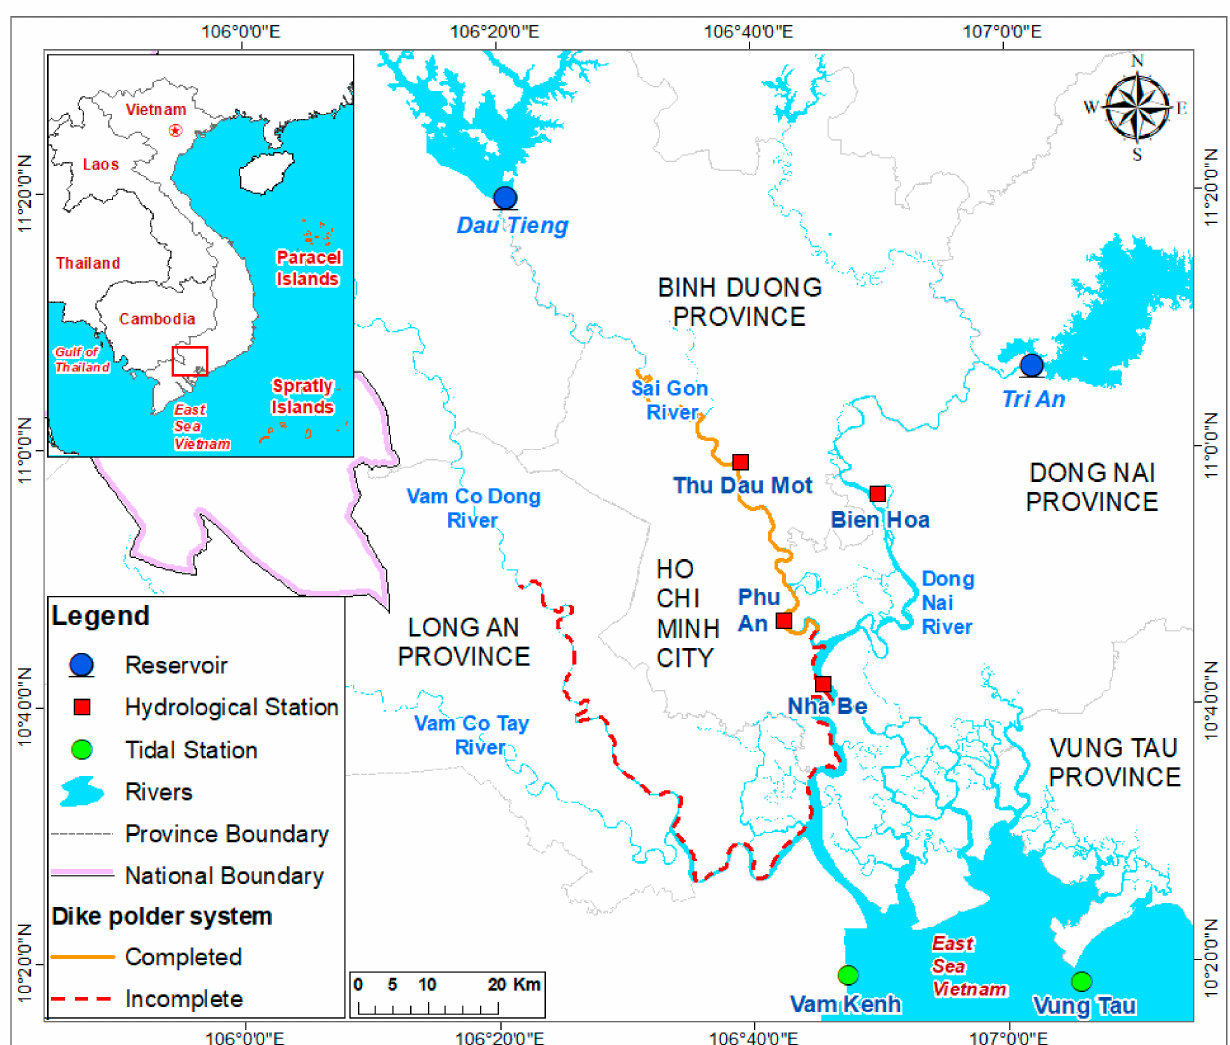
Figure 9. The dike polder system under the planning project No.